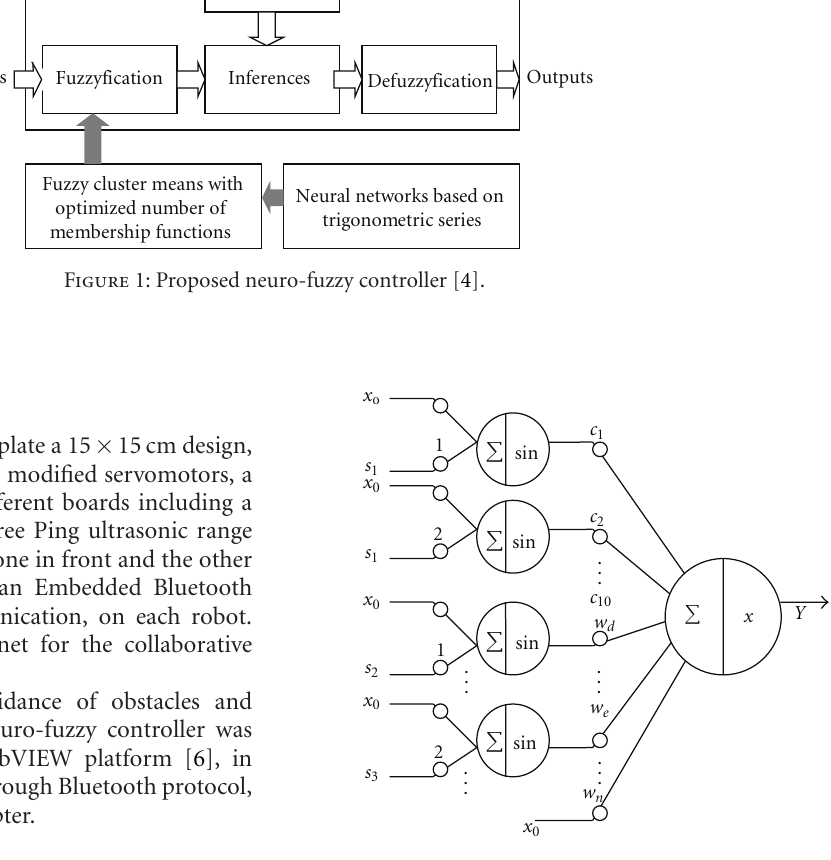
Figure 2: Topology of a trigonometric artificial neural network